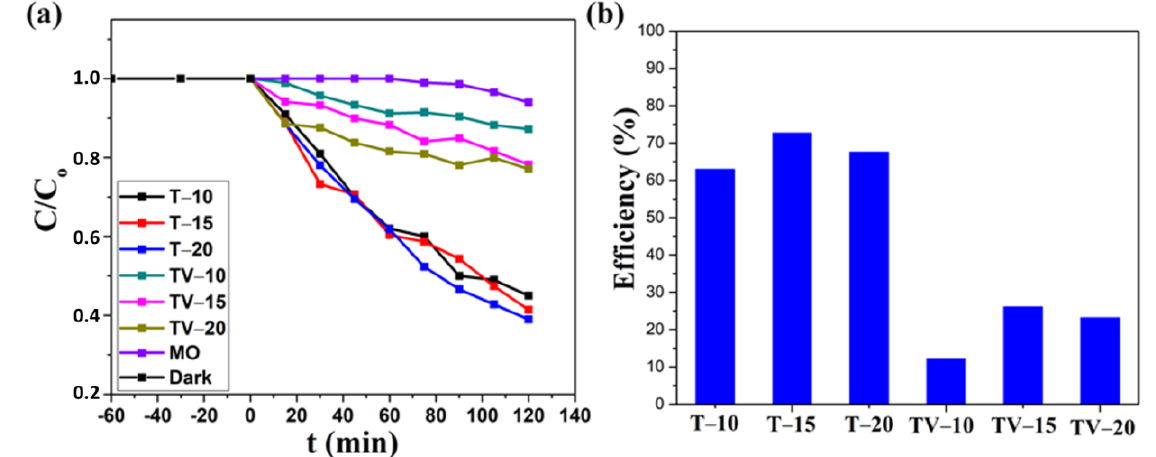
Figure 6. Photocatalytic activity ( a ) and efficiency ( b ) of decolorization MO by TiO 2 nanotubes with and without vanadium oxide.